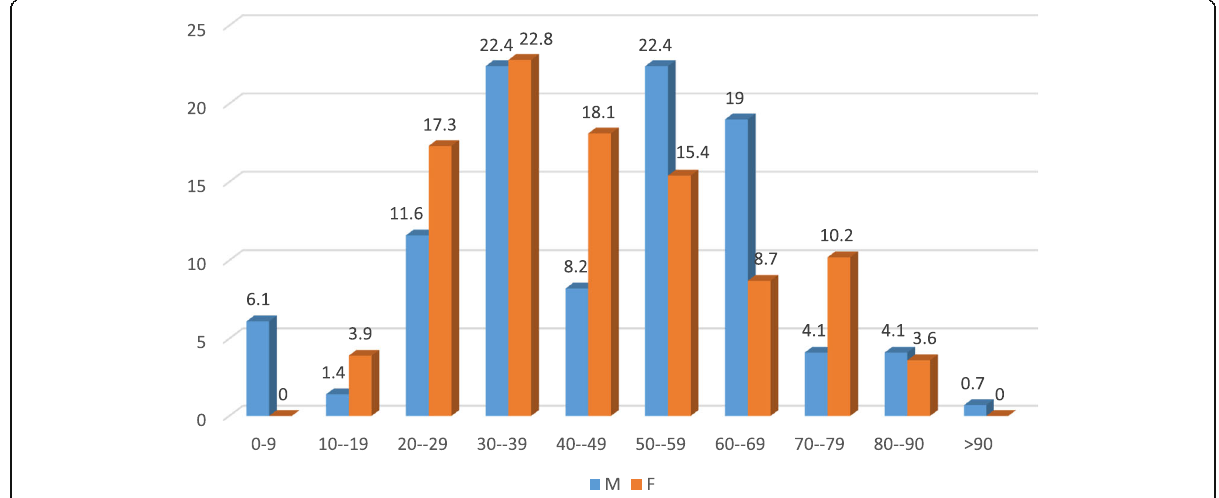
Fig. 1 Frequency distribution of the plaintiffs in complaints based on the plaintiffs ’ sex and age range into percentage